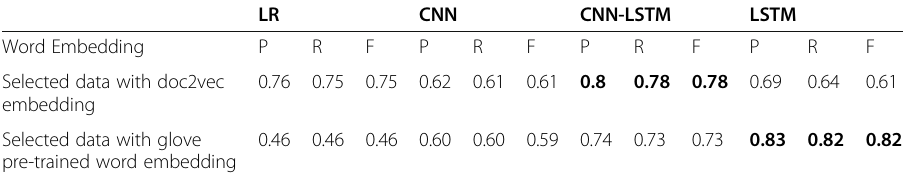
Table 4 Overall performance of various ML models using different word embedding on training data ( P, R, F denotes Precision, Recall, and F1 score, respectively ) LR CNN CNN-LSTM LSTM Word Embedding P R F P R F P R F P R F Selected data with doc2vec